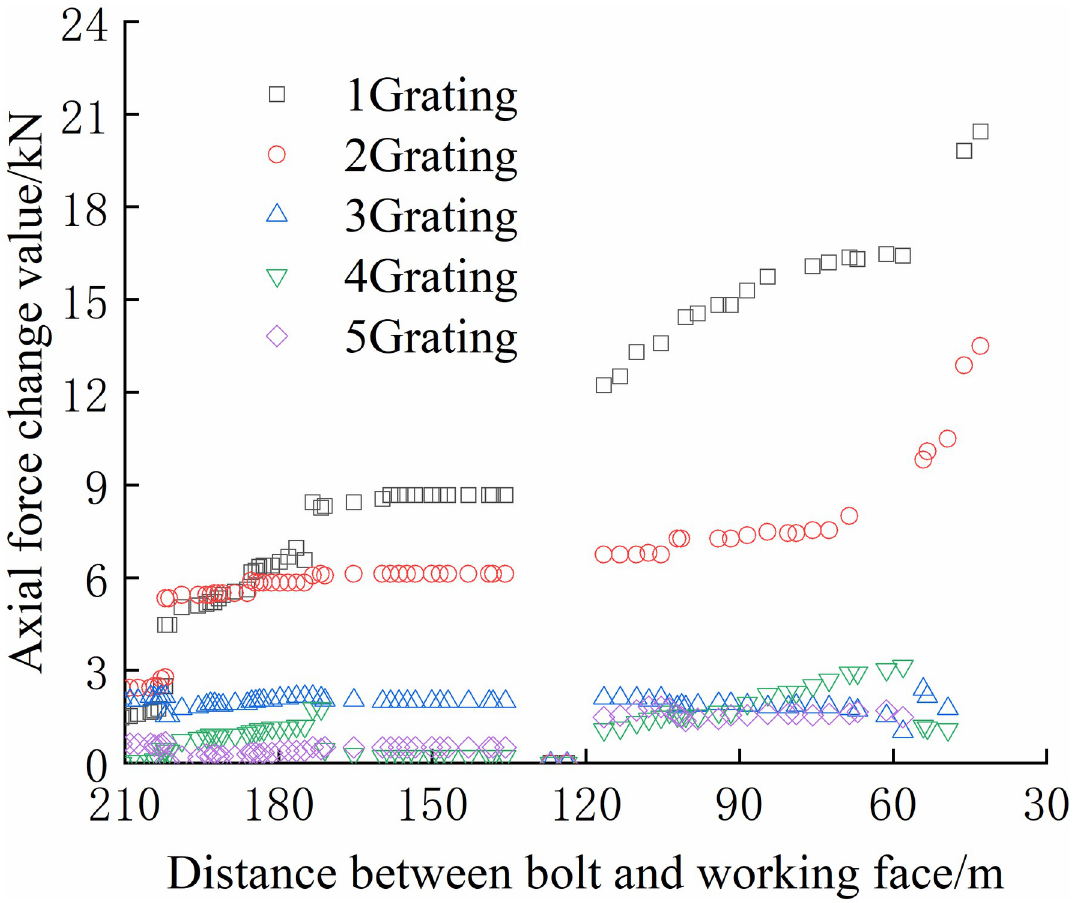
Fig 24. Axial stress monitoring test curve of No.1 bolt.